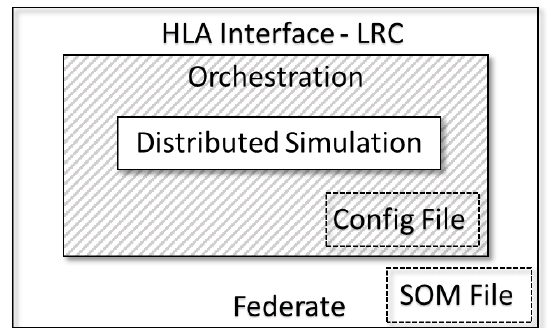
Figure 1. Layered view of a slave federate.